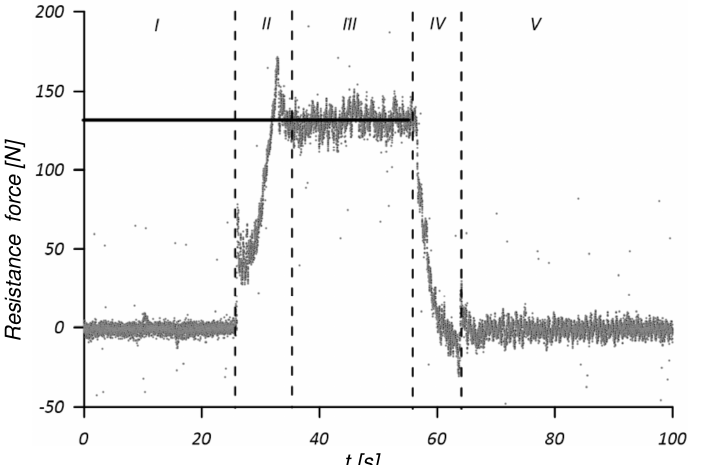
Figure 4. An example of measurement, I, V—idle phases, II—acceleration to required speed, III—constant speed,